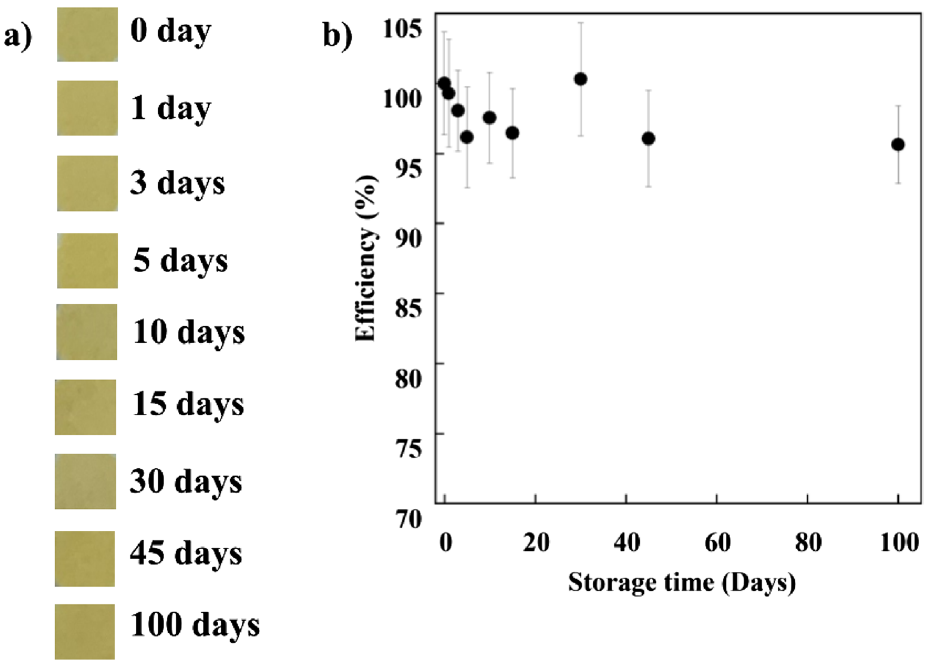
Figure 9. ( a ) Digital images of P-AgNPs-100 during storage and ( b ) storage stability of P-AgNP-100 for H 2 O 2 detection.